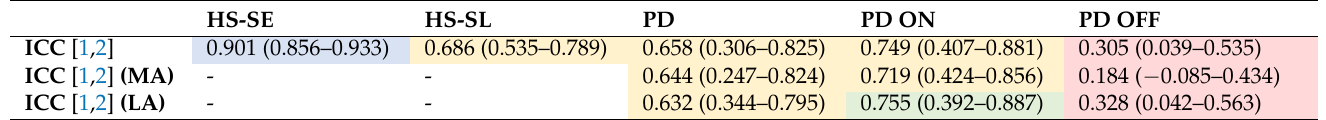
Table 2. Intraclass correlation coefficient between the number of steps recorded by GV4 and manual counting. ICC is reported as point estimate (CI 95%). The values are reported for at-selected speed and slow speed for healthy participants. In PD patients, values are reported in the overall population, in ON, in OFF, and for the most- and least-affected sides. HS-SE: Healthy subjects at self-selected speed; HS-SL: Healthy subjects at slow speed; ICC: Intraclass correlation coefficient. LA: Least-affected side; MA: Most-affected side; PD: Parkinson’s disease.